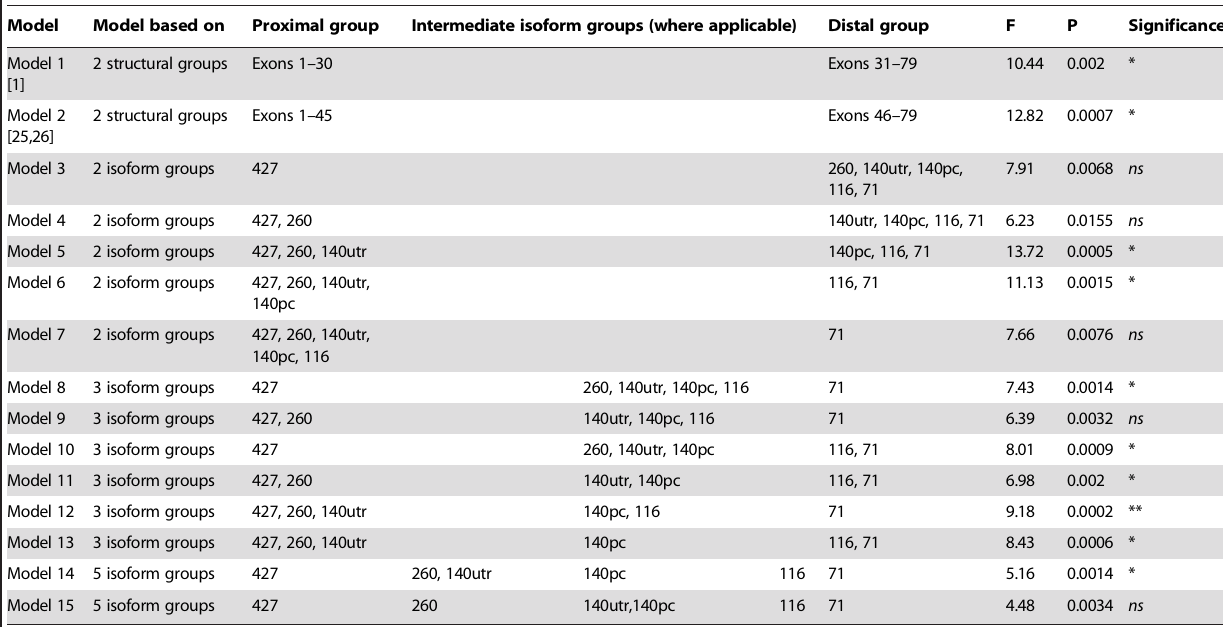
accounted for more of the variance than 2 group models based on the physical location of mutations proximal of exon 30 (F = 10.44; p = 0.002) or exon 45 (F = 12.82; p= 0.0007). Several three isoform groups were also assessed, but in no instance were the mean FSIQs significantly different in all three groups, as assessed